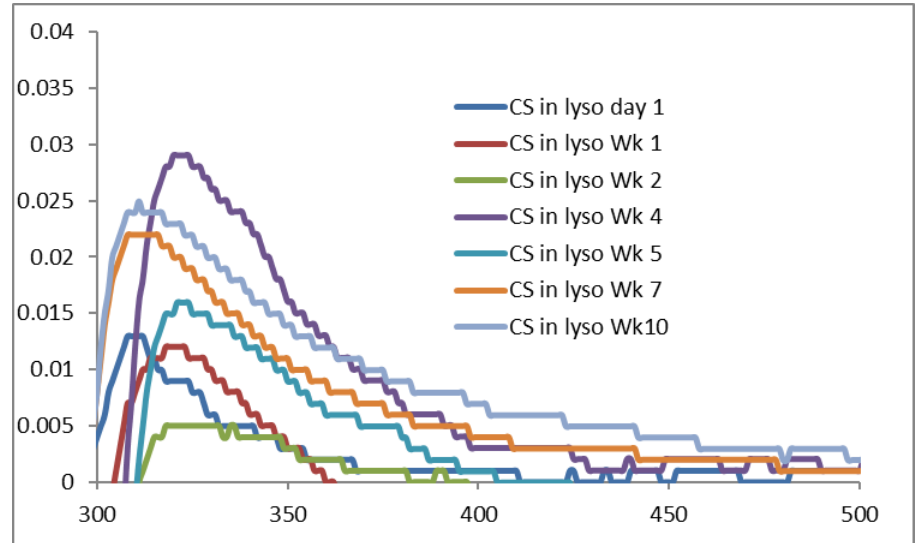
Figure 9. UV-VIS spectra of CS original powder incubated in 0.2% lysozyme solution at 37 °C.